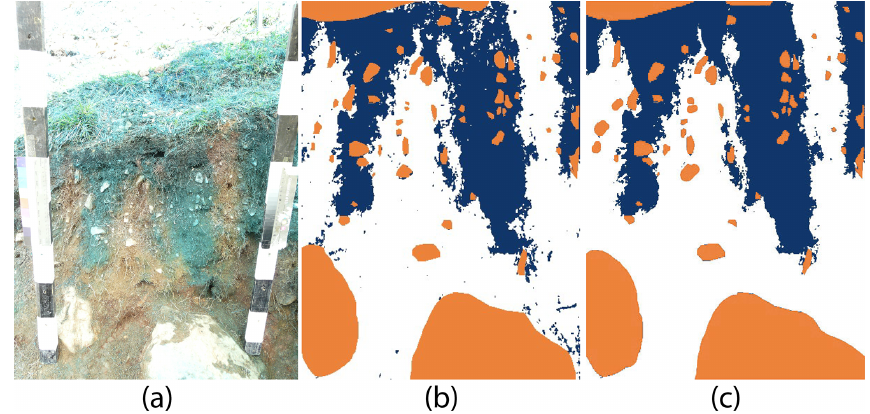
Figure 3. Exemplary image analysis procedure for the 40mm irrigated subplot at the 3000-year-old moraine. (a) Photograph of the vertical soil profile with a wooden frame and an attached grayscale. (b) Software-generated tricolor image of the photograph. (c) Manually